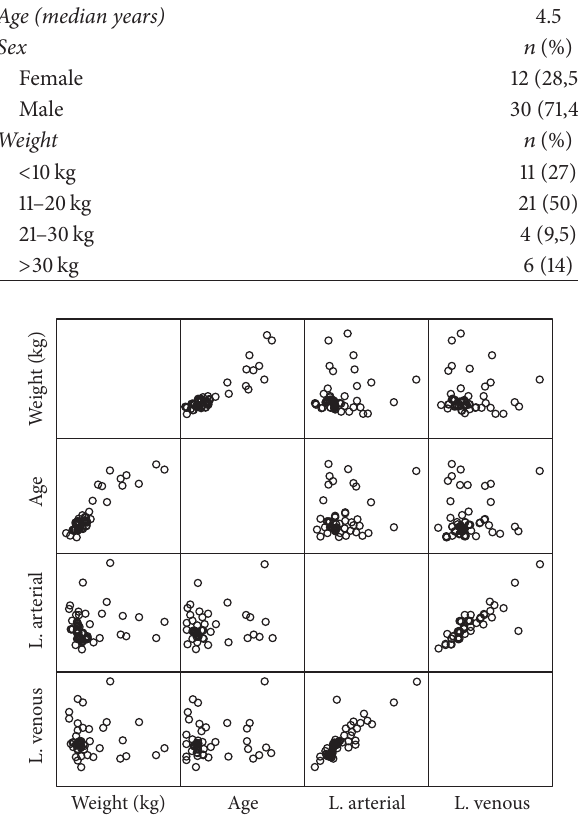
Figure 2: Dispersion diagram of the study variables.